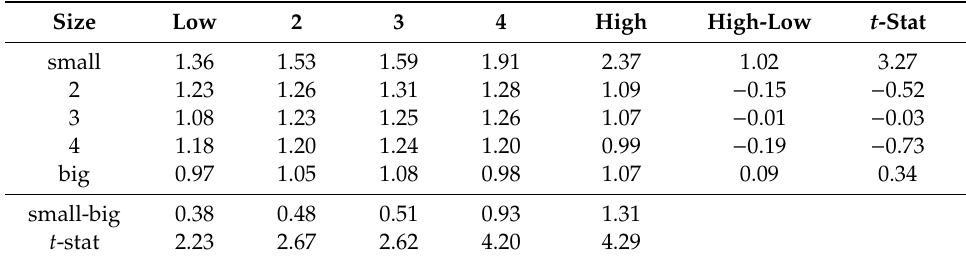
Table 7. Average returns from double-sorted quantile portfolios (sorted by size and Merton’s default probability). From the data for July 1963 to December 2013, at the end of each month, stocks are independently sorted into 5 × 5 portfolios based on size and Merton’s default probability. The table shows average returns for each of 25 portfolios. Small-big is the return di ff erential between the small and big firm portfolios within each default quantile. High-low is the return di ff erential between the high and low default probability firms within each size quantile. t -statistics are calculated using Newey-West standard errors.